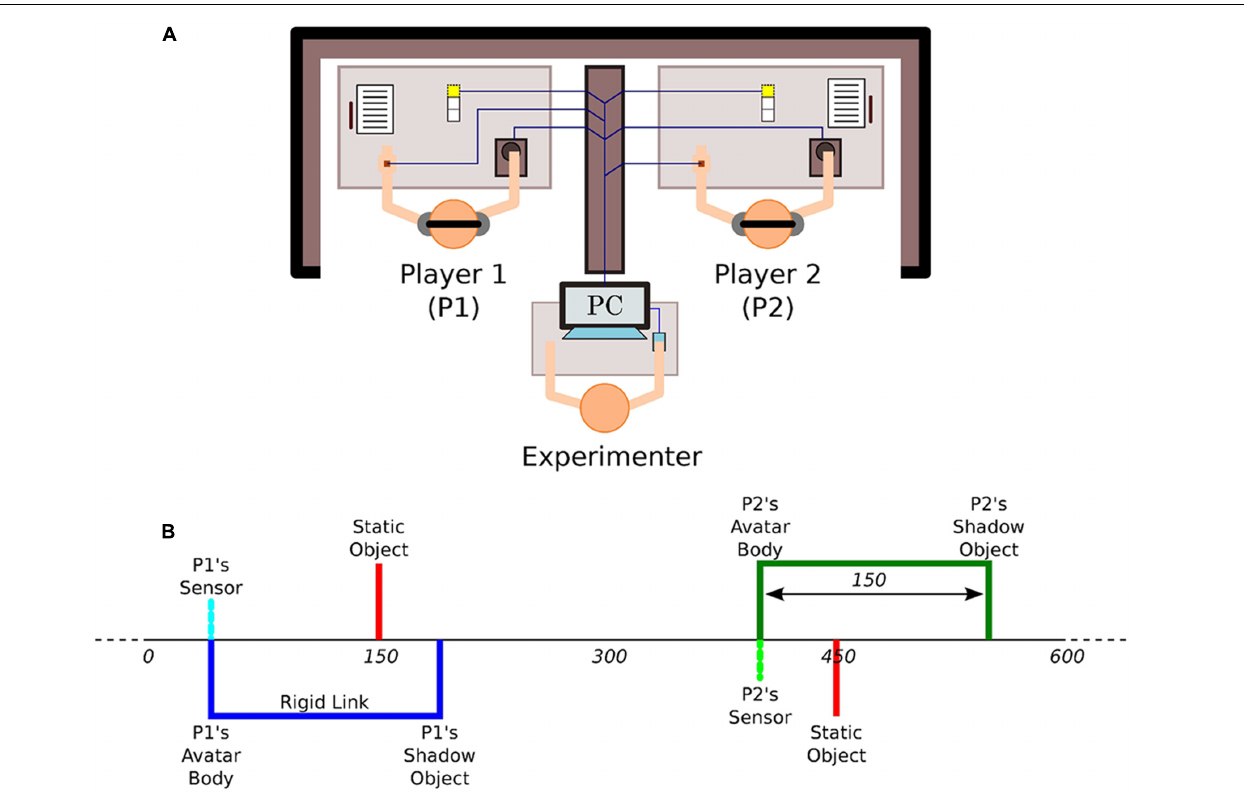
FIGURE 1 | Experimental set up. (A) The participants are placed in separate locations and can only interact with each other by means of a minimal haptic human–computer interface that provides all-or-nothing vibratory feedback depending on whether a player’s avatar overlaps with another virtual object or not. (B) The virtual space consists of an invisible 1D circle that wraps over after 600 units of space and in which players can encounter three different objects of equal size: the other’s avatar, the other’s shadow, and a static object. Adapted from Froese et al.